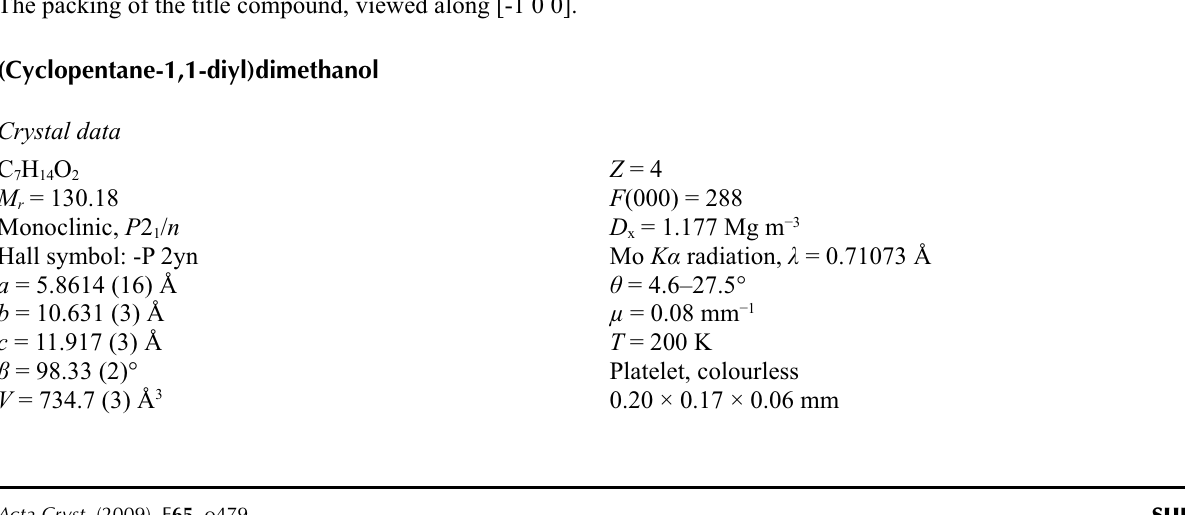
The packing of the title compound, viewed along [-1 0